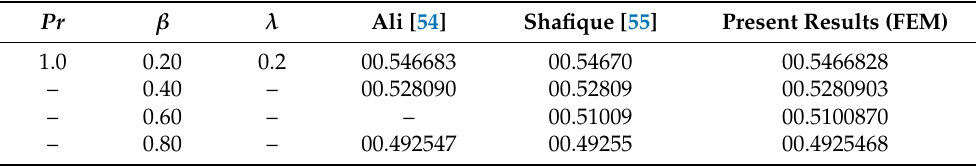
Table 3. Assessment of {− θ (cid:48) ( 0 ) } at ζ = 1 at various values of Pr , λ and other parameters are fixed at